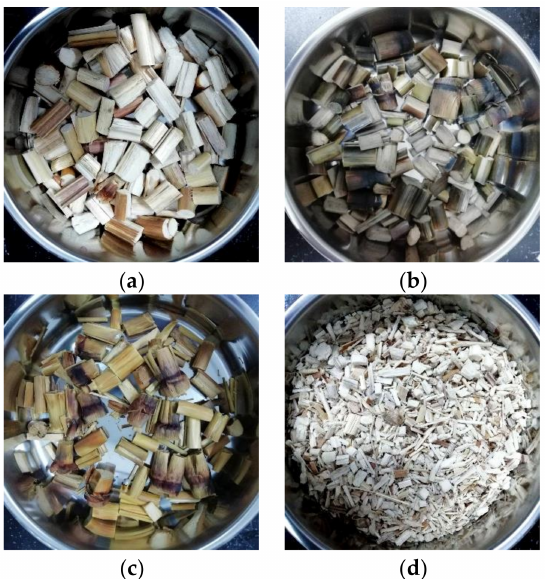
Figure 1. ( a ) Non-treated corn straw; ( b ) corn straw treated with acid (solid-liquid ratio 1:20, soaked in 20% HCl for 24 h, washed, and then dried to constant weight); ( c ) corn straw treated with alkali (solid-liquid ratio 1:30, soaked in 1% NaOH for 24 h, washed, and then dried to constant weight); and ( d ) comminuted corn